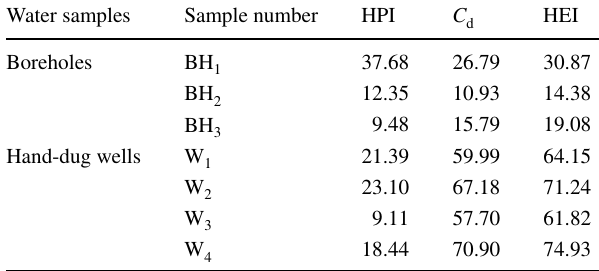
overall hazard indexes of groundwater samples from boreholes and hand-dug wells samples in the Oti community